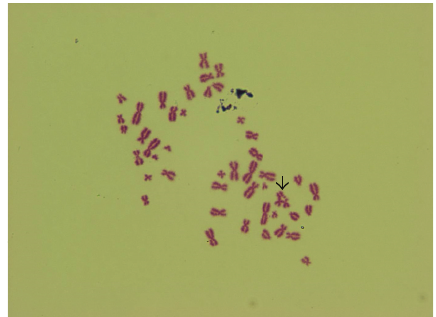
Figure 3: Chromatid exchange (250 𝜇 g/mL dirithromycin, 48 h treatment, D ).